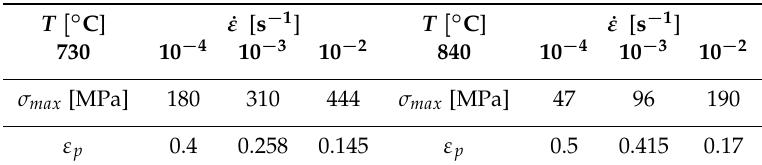
Table 1. Maximal stresses σ max achieved for the deformation ε p as a function of the strain rate ˙ ε and the temperature T